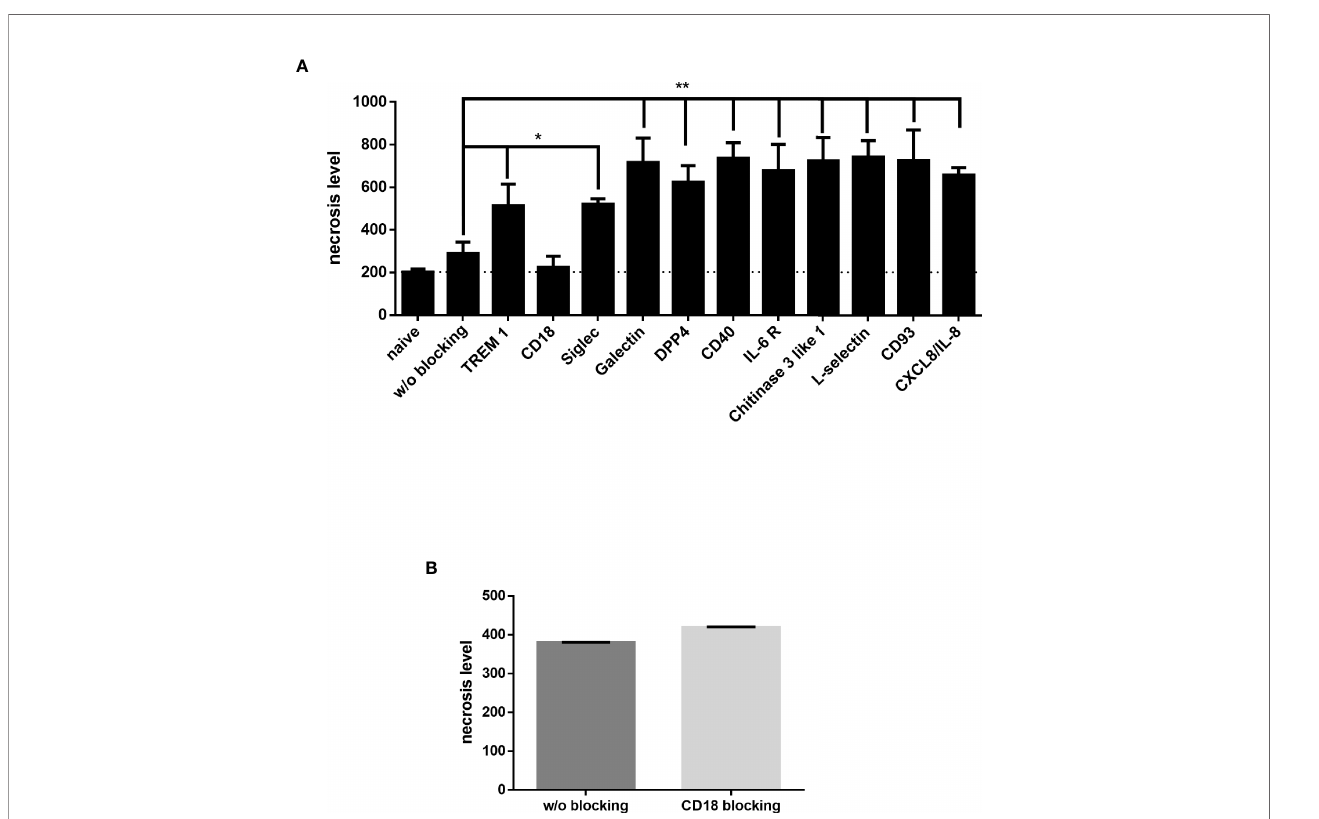
FIGURE 6 | Neutrophil blocking receptors. Neutrophils blocked with speci fi c antibodies were incubated with JP2 and cell necrosis (propidium iodide-positive cells in fl ow cytometry) was examined. (A) Necrosis level of differentiated HL60 blocked with speci fi c antibodies (*p< 0.05, **<0.001). (B) Necrosis level of MIPP neutrophils blocked with